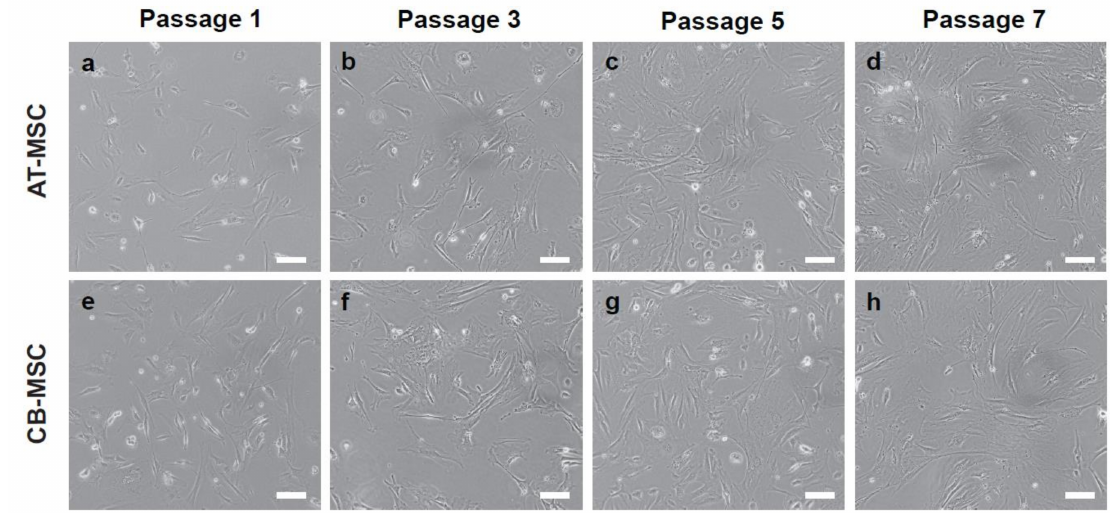
Figure 1. Cell morphology of AT-MSC and CB-MSC. Morphologies of MSCs at ( a , e ) passage 1, ( b , f ) passage 3, ( c , g ) passage 5, and ( d , h ) passage 7 were shown. Cell morphology changed gradually from spindle-like to flat and fibroblastoid with increasing passage number. Representative images were taken at 20 × magnification. Scale bars: 100 µ